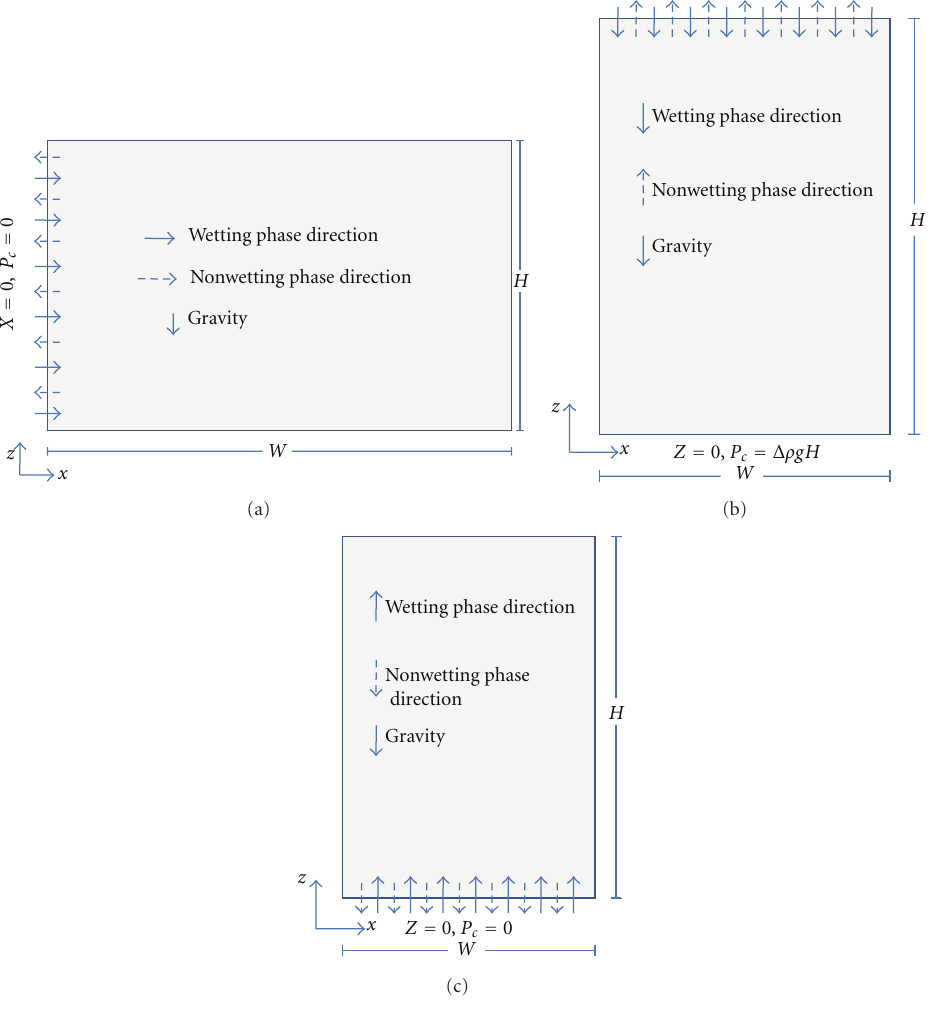
Figure 1: Schematic diagram of countercurrent imbibition with gravity e ff ect for di ff erent locations of the open boundary: (a) side, (b) top, and (c)